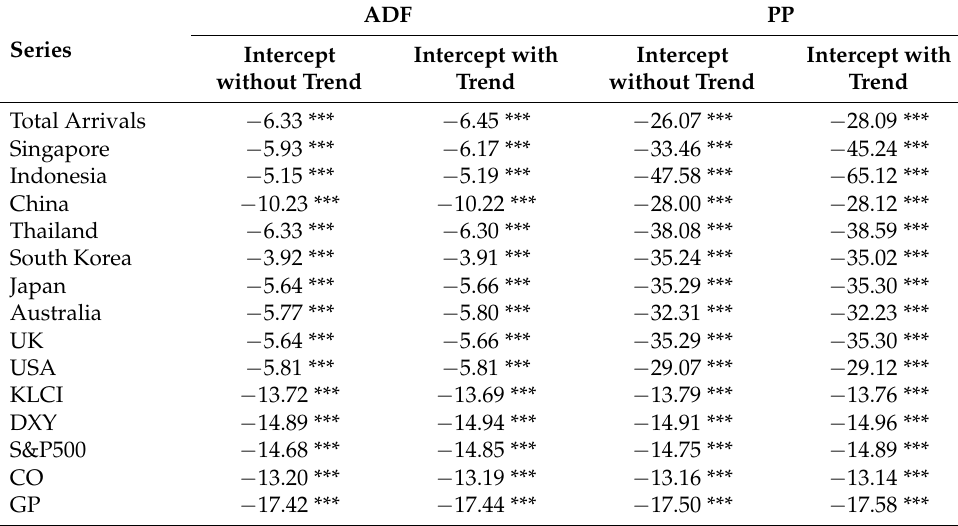
Table 4. Unit Root